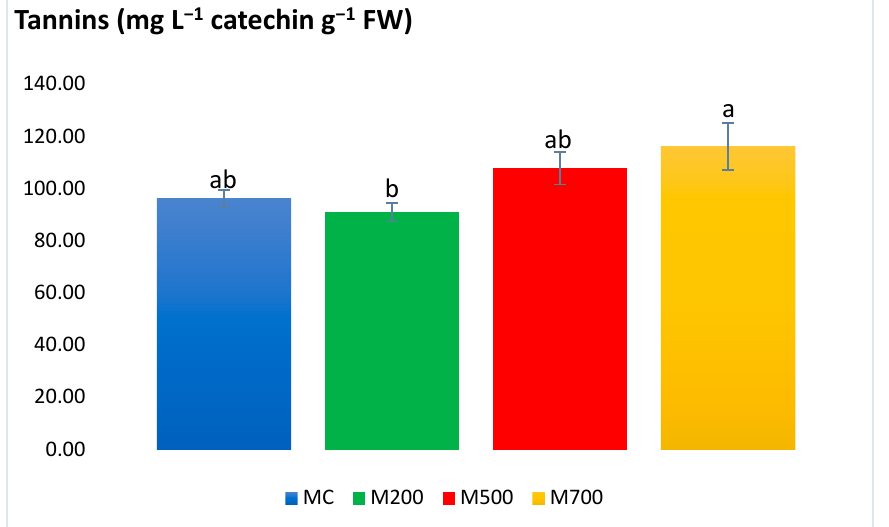
Figure 9. Concentration of tannins in the leaves of Mis-B cultivar cultivated in soils with gradient T.E. concentrations (MC, M200, M500, M700). Values are presented as mean ± SE. Di ff erent le tt ers refer to signi fi cant di ff erences between plants (Tukey HSD test, n = 6, p ≤ 0.05) .